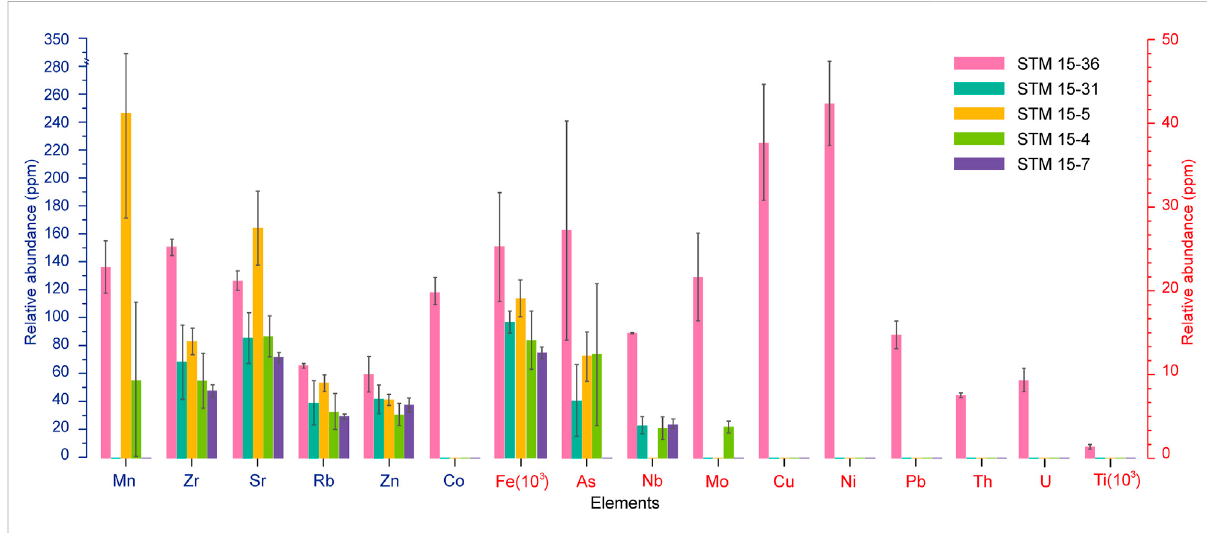
FIGURE 4 Element distribution of the host sediments from Sapeornis specimens.